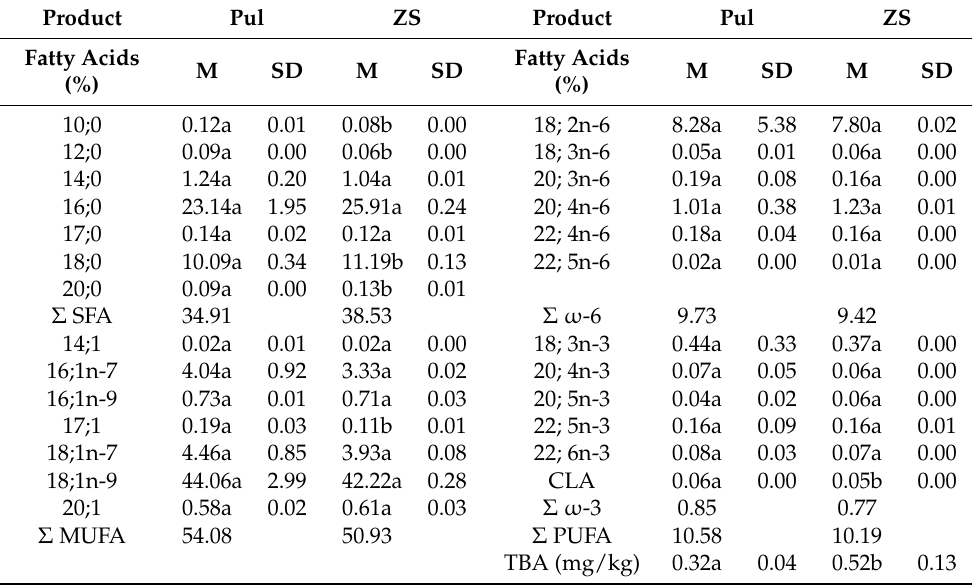
Table 4. One-factor analysis of the variance of the fatty-acid content and TBA index of dry-cured